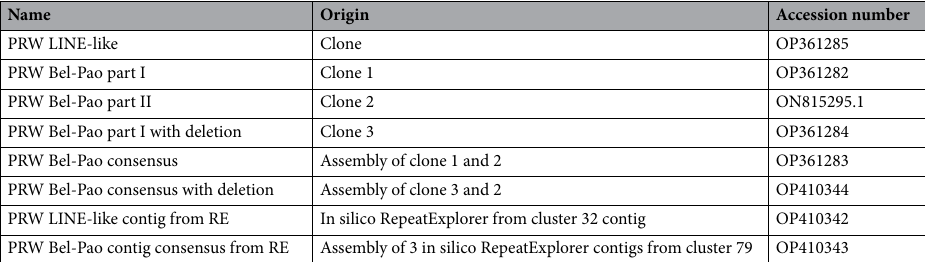
Table 1. Accession numbers of studied